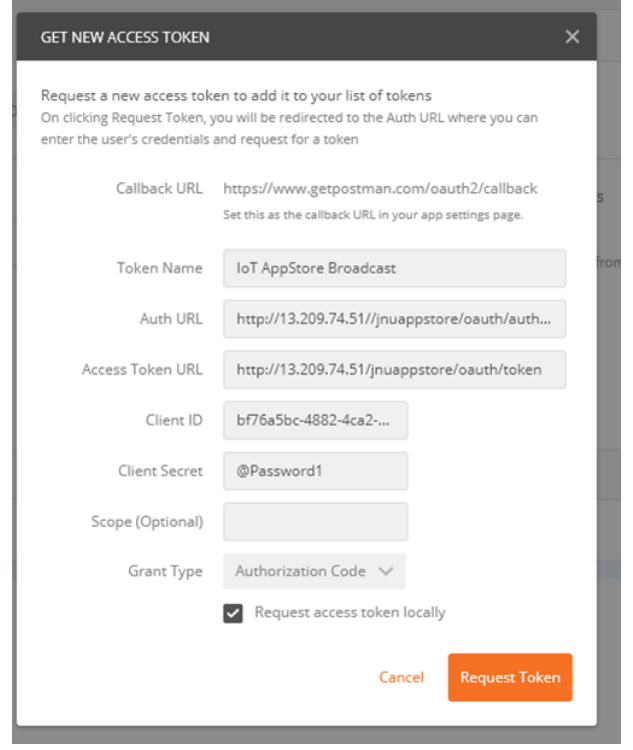
Figure 5. Authorization code grant request using